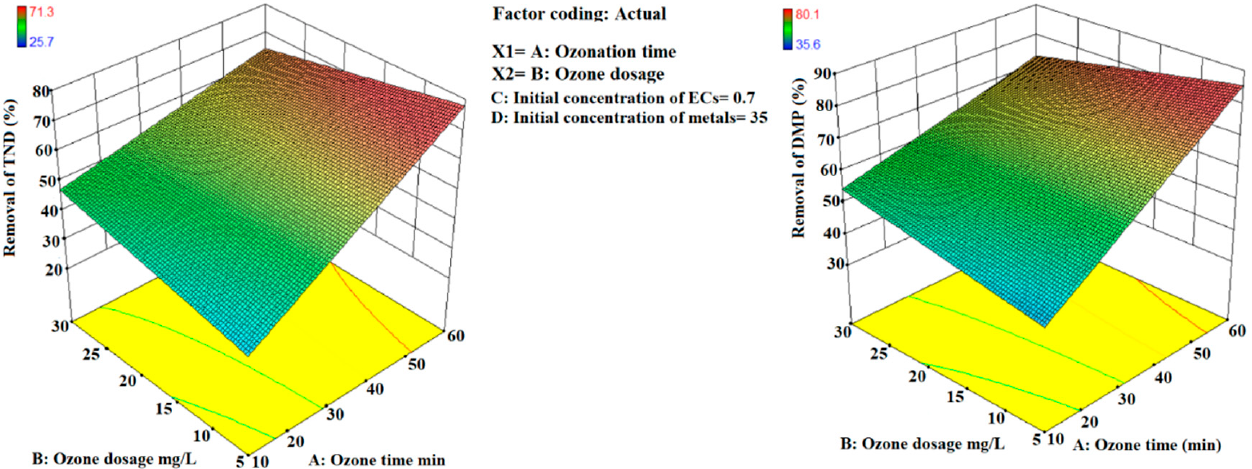
Separations 2022 , 9 , x FOR PEER REVIEW